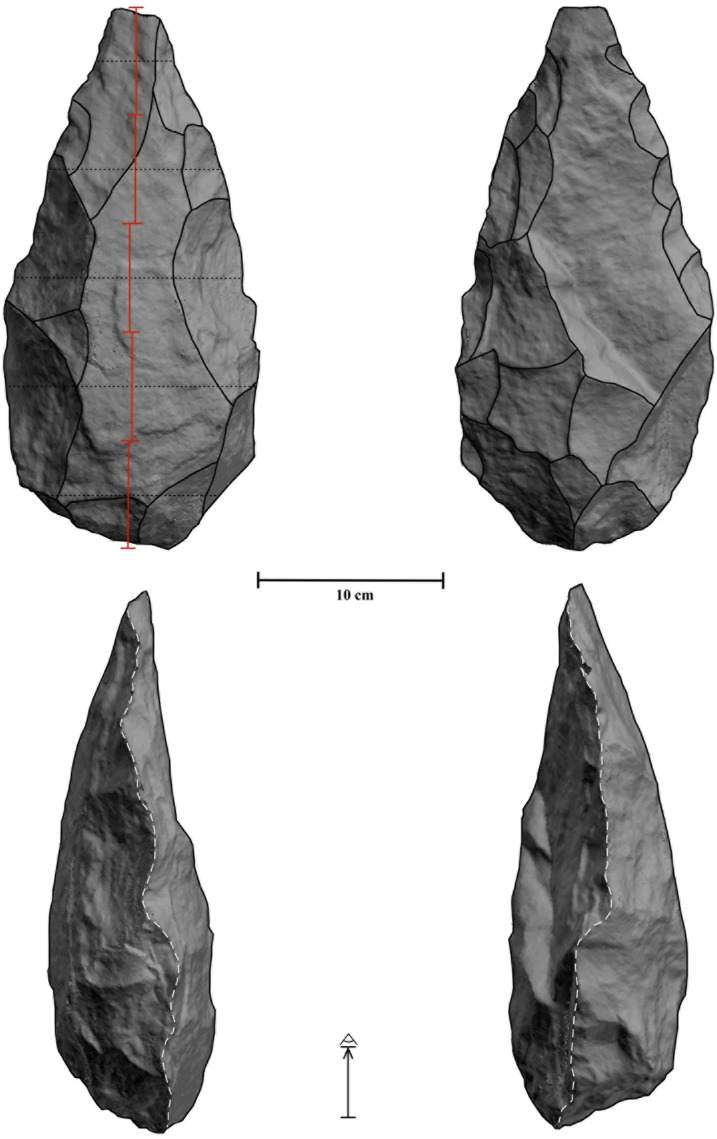
Biface from FLK W.3D model of the refined handaxe and its tool functioning schemes. Note its accurate frontal symmetry.